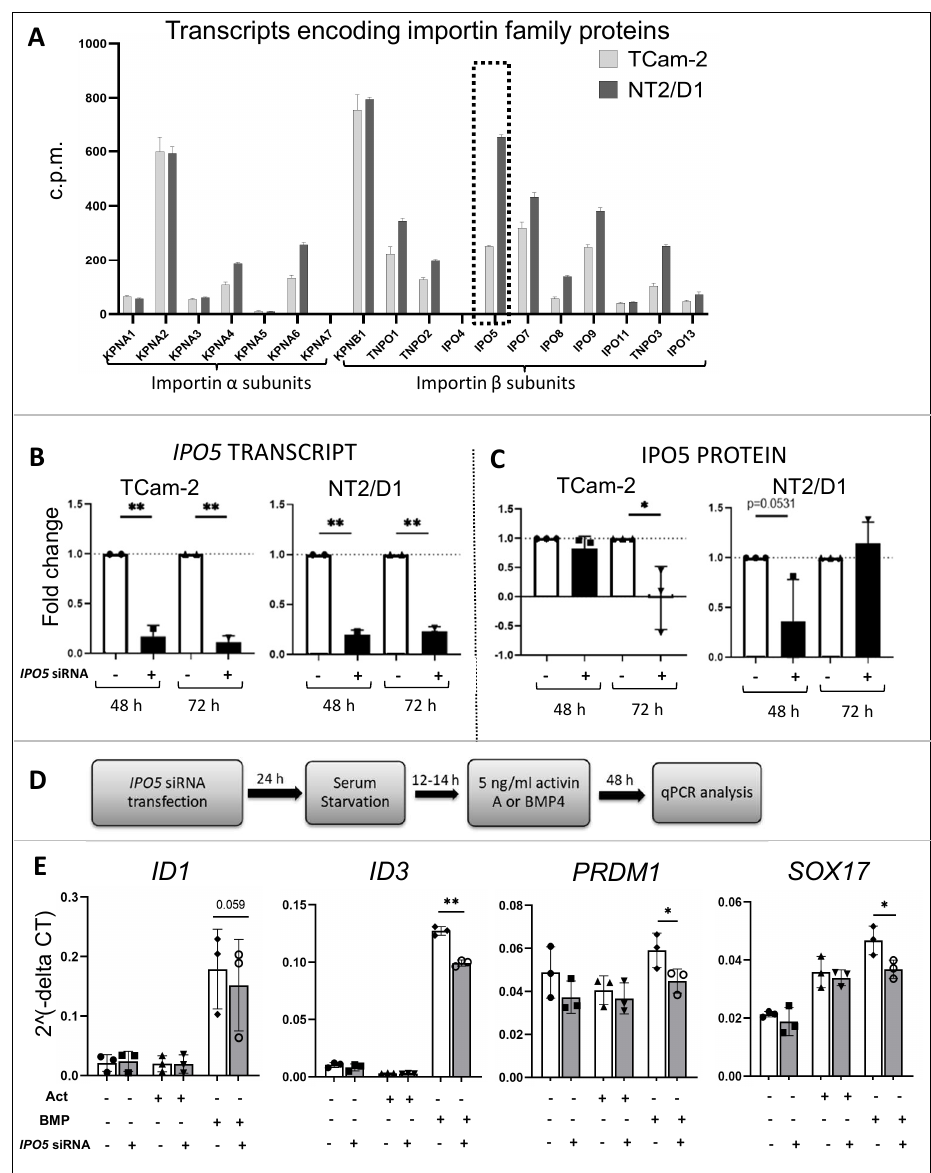
Figure 5. Importins in TCam-2 and NT2/D1 cells, and a role for IPO5 in BMP4